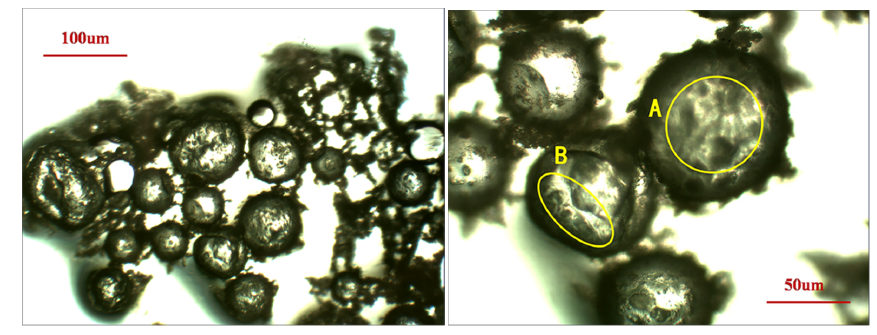
Figure 6. Optical microscopy images of microcapsules prepared.